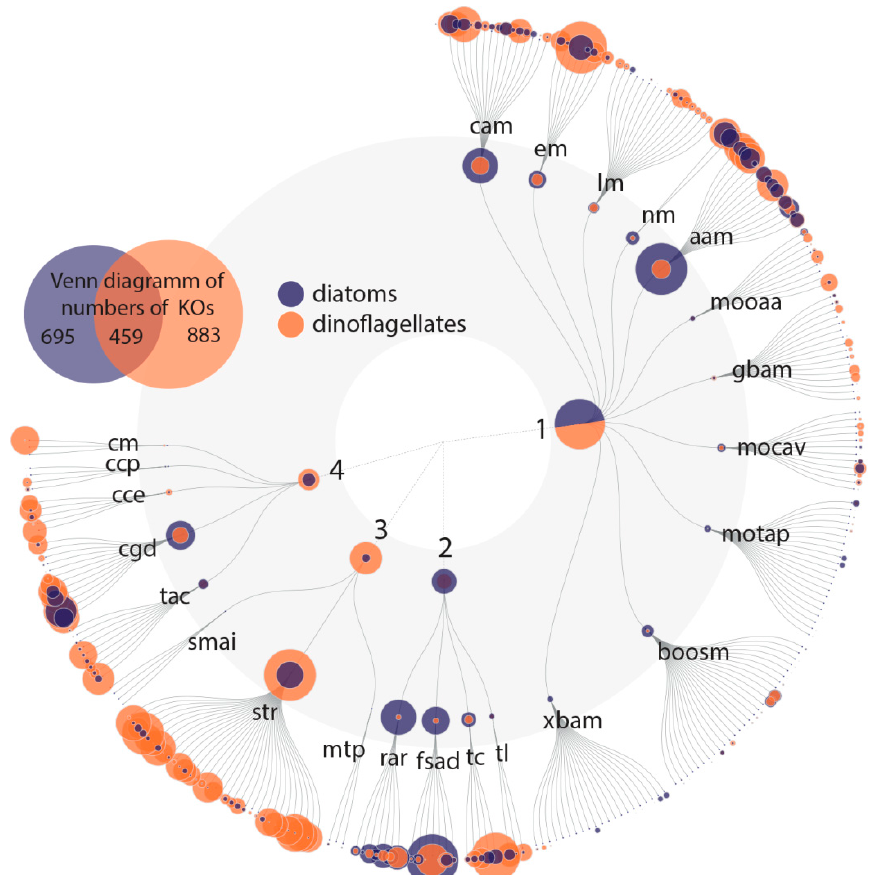
Figure 5. FuncTree 2 Plot: positive correlation with Pfam domains for which variability is most likely related to changes in the abundance of diatoms or dinoflagellates. The KEGG biologic categories are metabolism (1) : carbohydrate metabolism (cam), energy metabolism (em), lipid metabolism (lm), nucleotide metabolism (nm), amino acid metabolism (aam), metabolism of other amino acids (mooaa), gylcan biosynthesis and metabolism (gbam), metabolism of cofactors and vitamins (mocav), metabolism of terpenoids and polyketides (motap), biosynthesis of other secondary metabolites (boosm) and xenobiotics biodegradation and metabolism (xbam); genetic information processing (2): replication and repair (rar), folding, sorting and degradation (fsad), transcription (tc) and translation (tl); environmental information processing (3): signaling molecules and interaction (smai), signal transduction (str) and membrane transport (mrp); and cellular processes (4): cell motility (cm), cellular community–prokaryote (ccp) / eukaryotes (cce), cell growth and death (cgd) and transport and catabolism (tac). KO abundance was counted and plotted (size = relative abundance of KOs in each plot). The Venn diagram shows the overlapping KOs between diatoms and dinoflagellates. Some KOs mainly appear in dinoflagellates (e.g., environmental information processing), whereas for genetic information processing some KOs can be found only in diatoms.